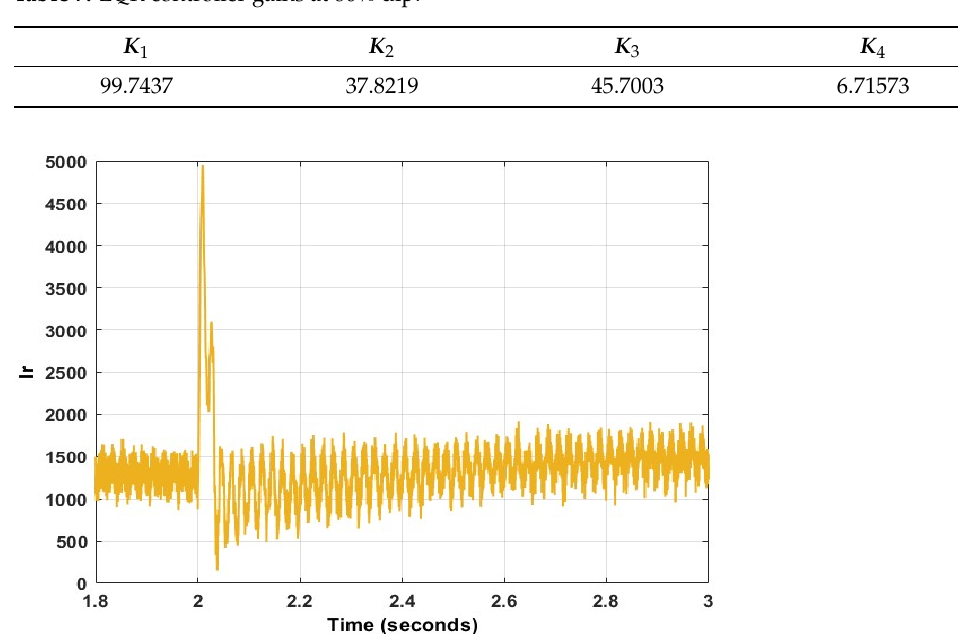
Figure 41. Rotor current transient using LQR at 80% dip.